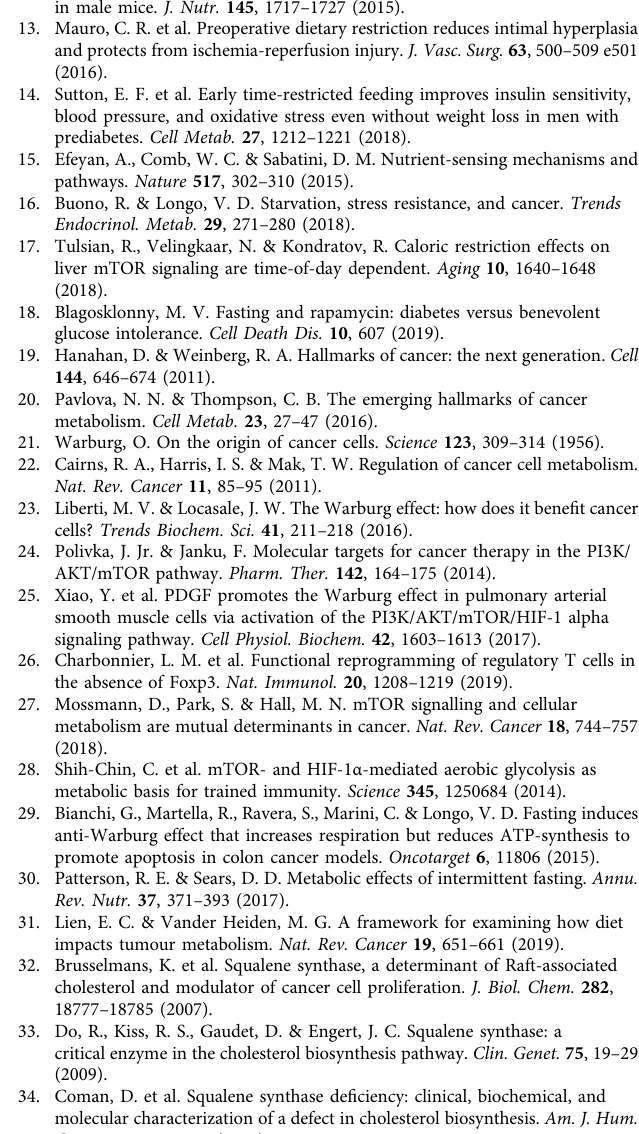
Fig. 7 Fasting and mTOR inhibitor synergize in suppressing CRC proliferation and clinical signi fi cance of the FDFT1/AKT-mTOR-HIF1 α pathway in CRC patients. a CT26 cells were injected into BALB/c mice. When the tumors were palpable, the mice were randomly assigned to the normal diet group, FMD group, the rapamycin 1 mg/kg group and FMD + rapamycin 1 mg/kg group. Photograph of dissected tumors (the fi rst line: normal diet, the